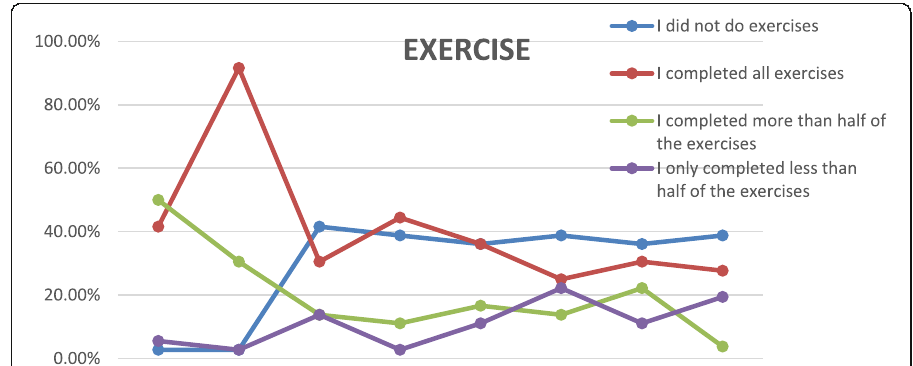
Fig. 5 The results of doing online exercises. The abscissa indicates the number of times students need to complete an online exercise, and the ordinate indicates the completion rate of an online exercise. In the figure, the number of students completing online exercises each time is much higher than the number